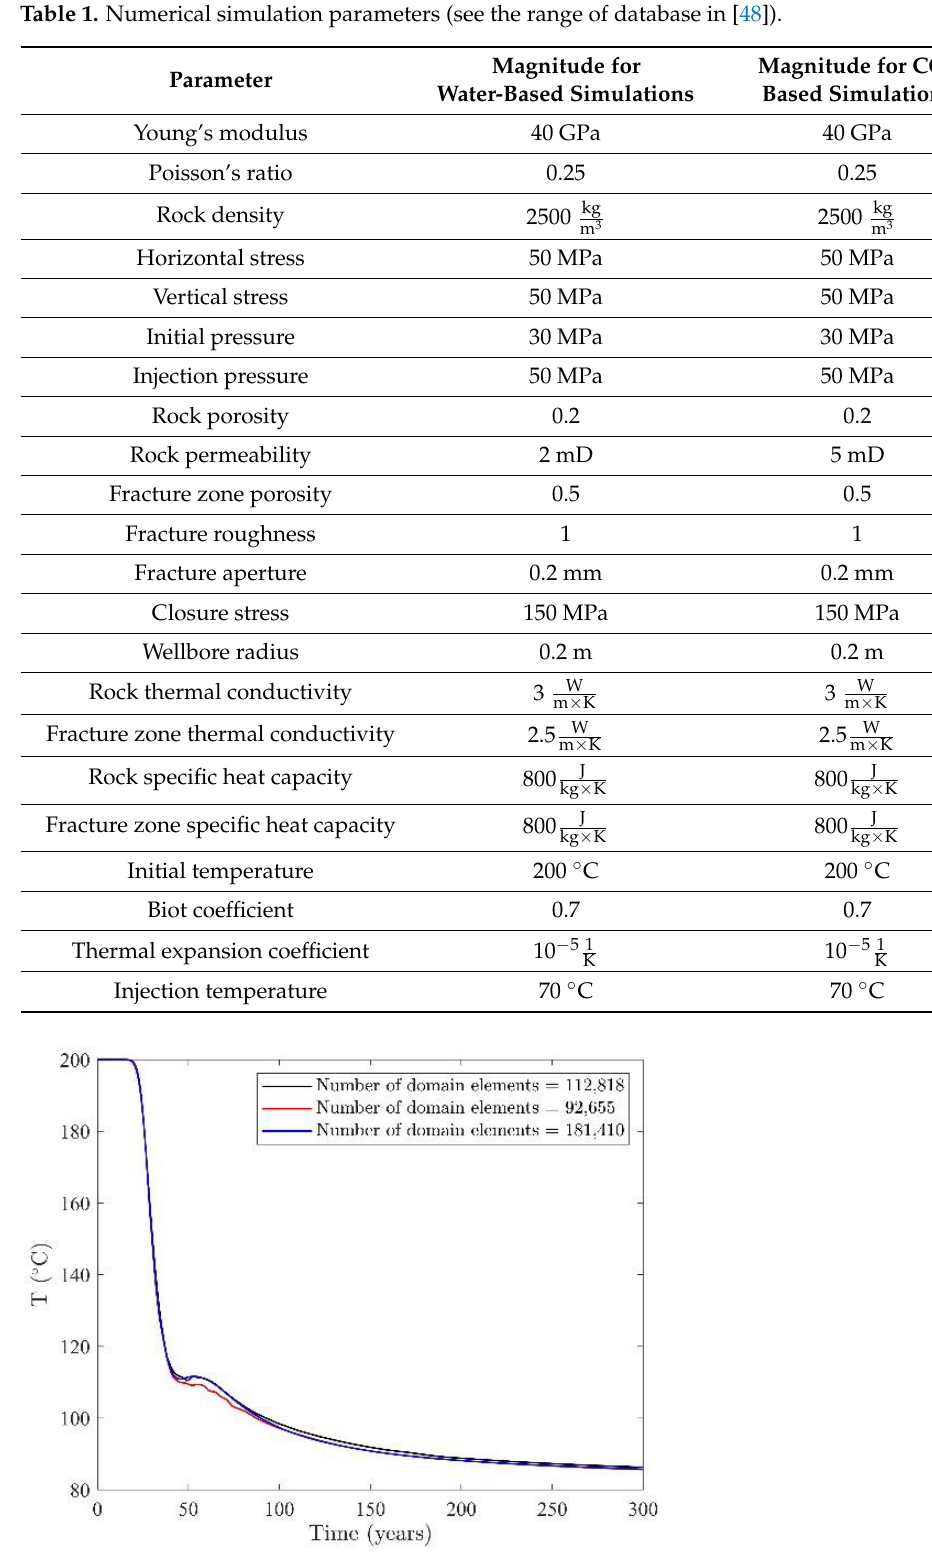
Figure 3. Mesh sensitivity results for three different number of mesh elements.